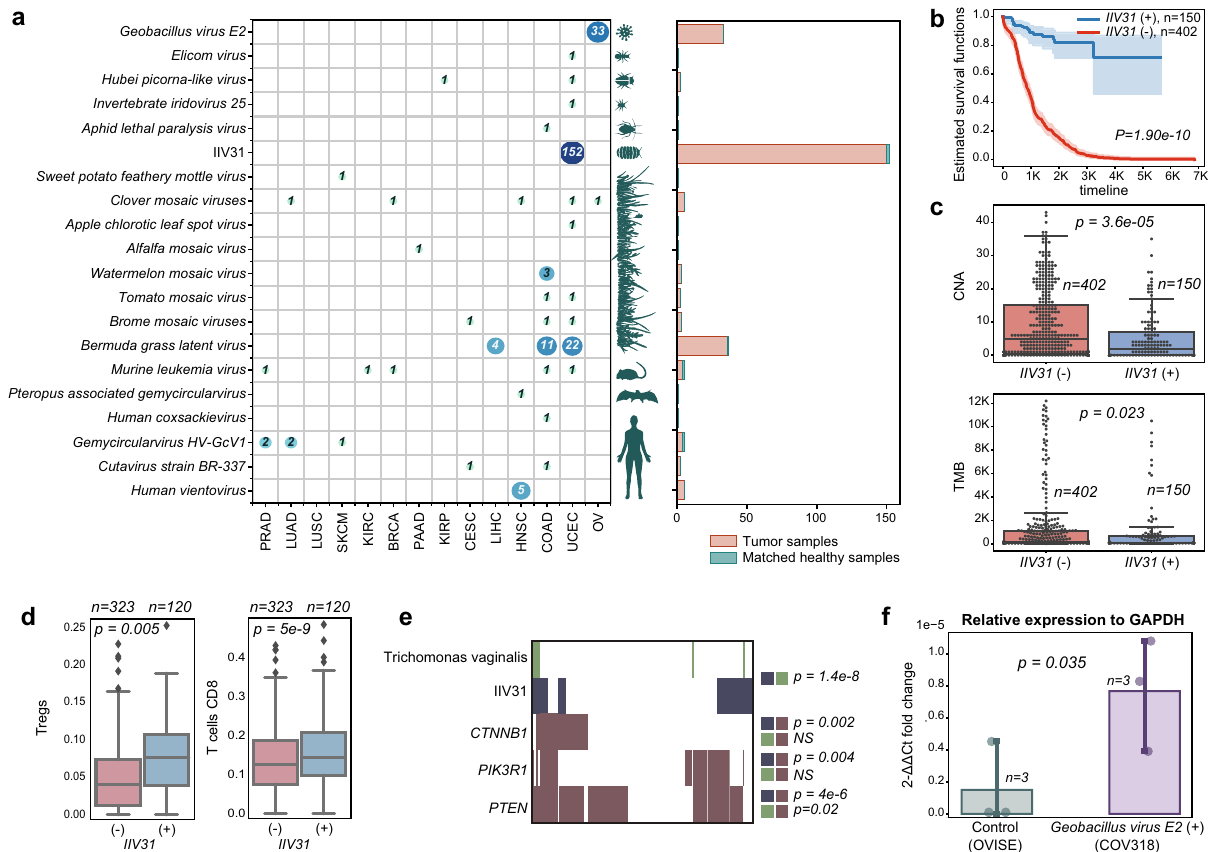
Fig. 4 | Unexpected and divergent viruses infecting different host taxa across TCGA samples. a Unexpected and divergent viruses expressed in TCGA samples. Eachrowinthe matrixrepresents onevirusand the entryineach columnindicates the number of cancer samples of each type in which each virus was detected. The canonical hosts of each virus are depicted at the left of the matrix. At right, the aggregatenumberoftumorandnormalsamplescontainingreadsofeachvirusare shown in a bar plot. b Kaplan – Meier curves comparing the survival rates between patientsinwhichIIV31readsweredetected(bluecurves)vsthosewhereviralreads were not detected (red curves). For Kaplan – Meier curves, shaded areas represent the con fi dence interval of survival. The log-rank p value is reported. c Box plots comparingthechromosome-levelcopynumberalteration(CNA,toppanel)andthe tumormutation burden (TMB,bottom panel)between cancer patients whereIIV31